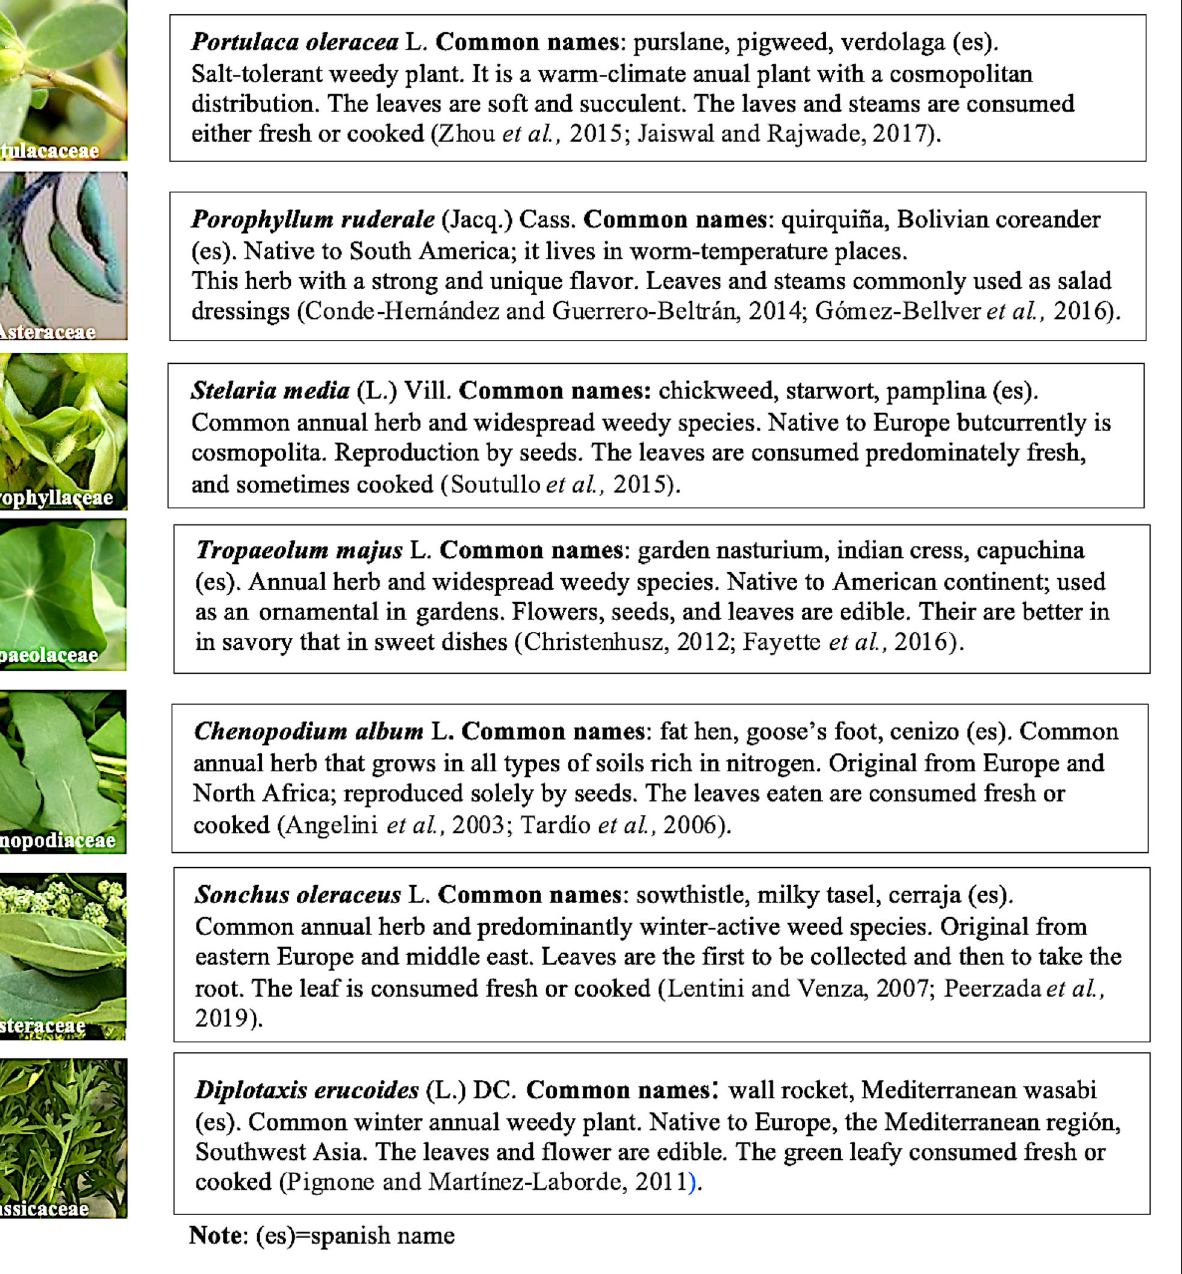
Cooperative in the rural environment areas of the coast of the province of Valencia (Spain). The area is located within 39 ◦ 45’13” North and 0 ◦ 12 ′ 21 ′′ West, with SCI code ES0000148 (35). A brief description of each plant is summarized in Figure 1 . The undervalued species with abundance in their respective season appear spontaneously and present as weeds. Samples of these fresh plants were manually cleaned to remove soil particles, and whole leaves were selected for